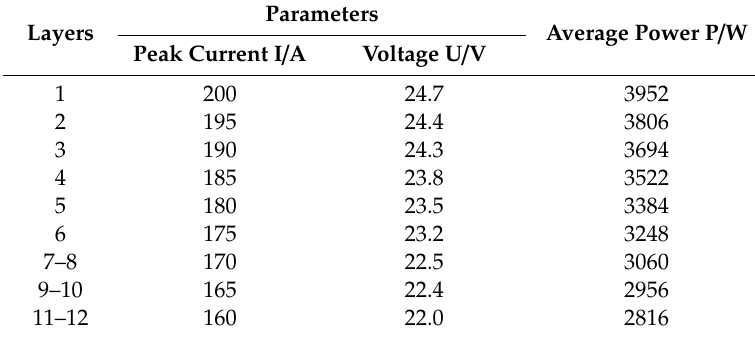
Figure 3. The IN738LC thin wall fabricated by PPAAM. Table 2. Main process parameters of PPAAM.